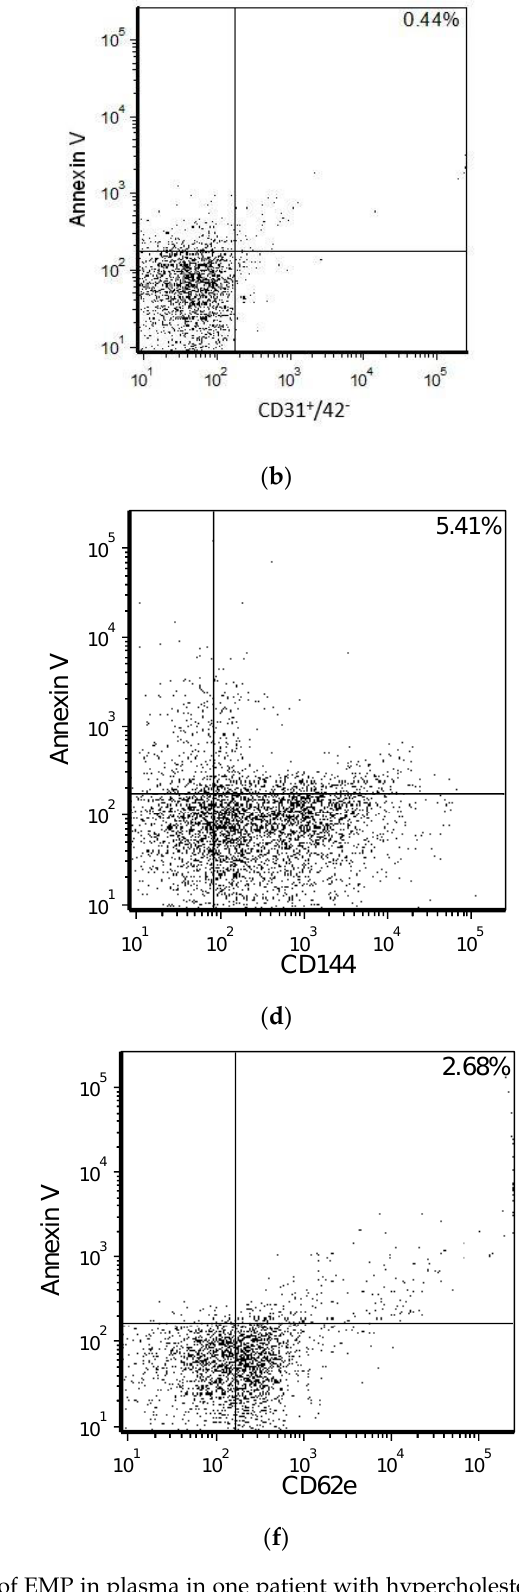
Figure 1. Representative FACS plots of EMP in plasma in one patient with hypercholesterolemia ( a , c , e ) and from one normal control ( b , d , f ). An increased CD31 + /42 − /AV + ( a ) vs. ( b ), CD144 + /AV + ( c ) vs. ( d ) and CD62e + /AV + ( e ) vs. ( f ) in plasma of patient with hypercholesterolemia in contrast to normal control.